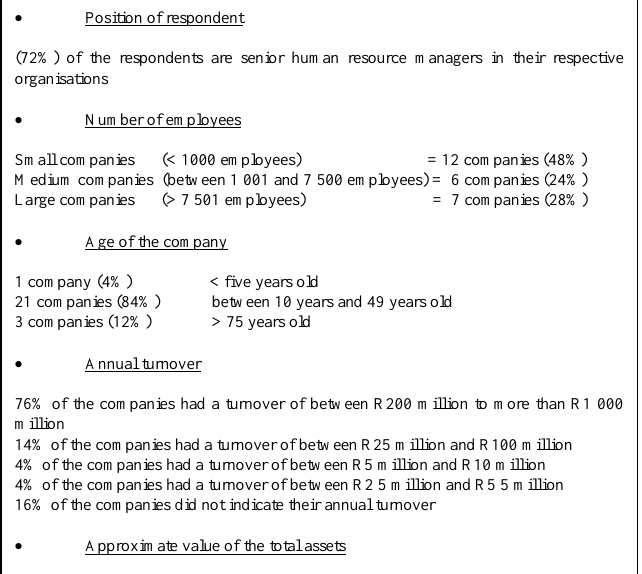
Table 5: Business practices of the sample companies (